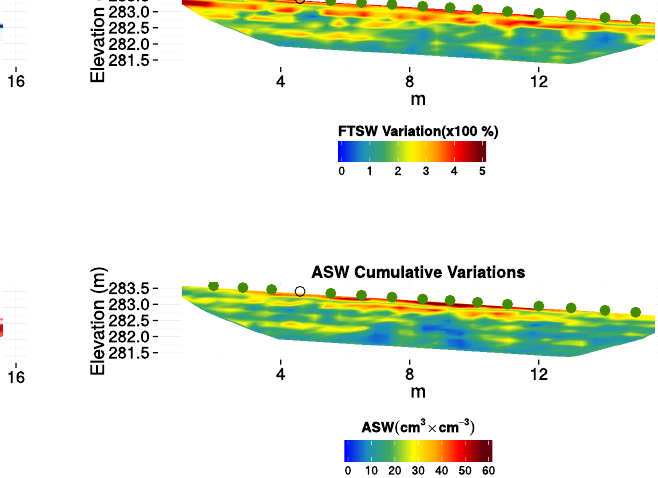
Figure 4. Cumulative variations of FTSW and ASW in a vine- yard soil. These were obtained by summing the absolute values of the variations between two successive measurements for these vari- ables (28 measurements). Green-filled dots represent fully devel- oped plants and empty dots represent very young plants (1